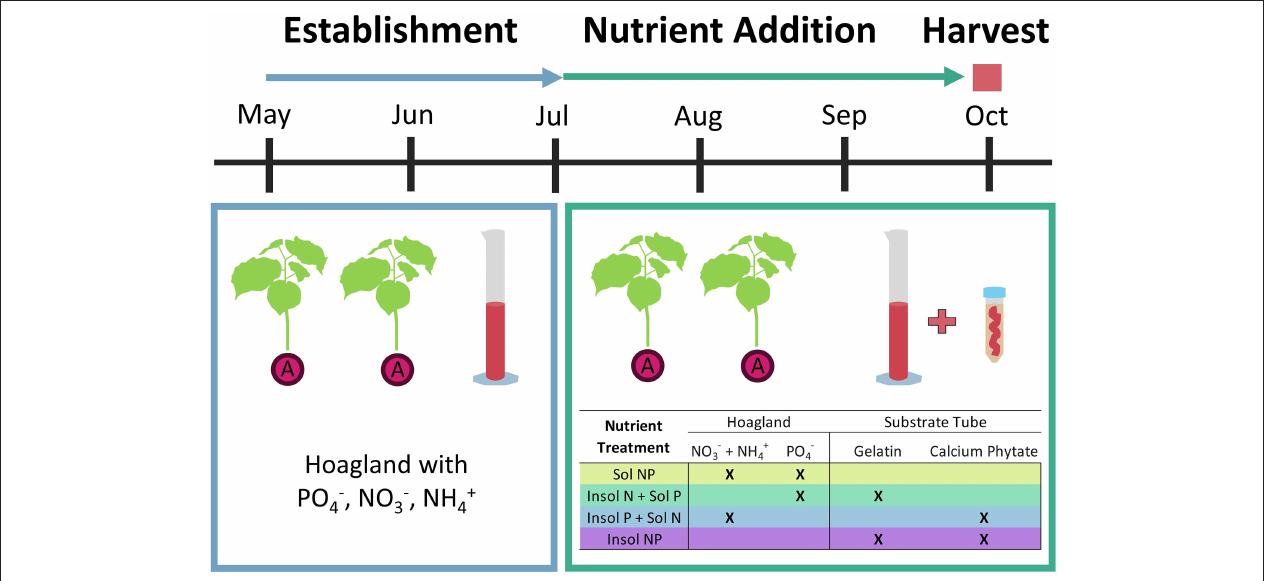
FIGURE 1 | The above diagram depicts the two phases of this experiment before harvest with each mesocosm represented by two AMF-colonized velvetleaf plants. During the establishment period, we applied Hoagland’s solution (which contained both soluble N and P sources) to encourage plant establishment: adjusting to mesocosm and greenhouse conditions and forming relationships with mycorrhizal populations. In the nutrient addition period, we applied different combinations of modified Hoagland solutions (see table) and substrate tubes with insoluble N and/or P sources to better quantify mycorrhizal nutrient uptake